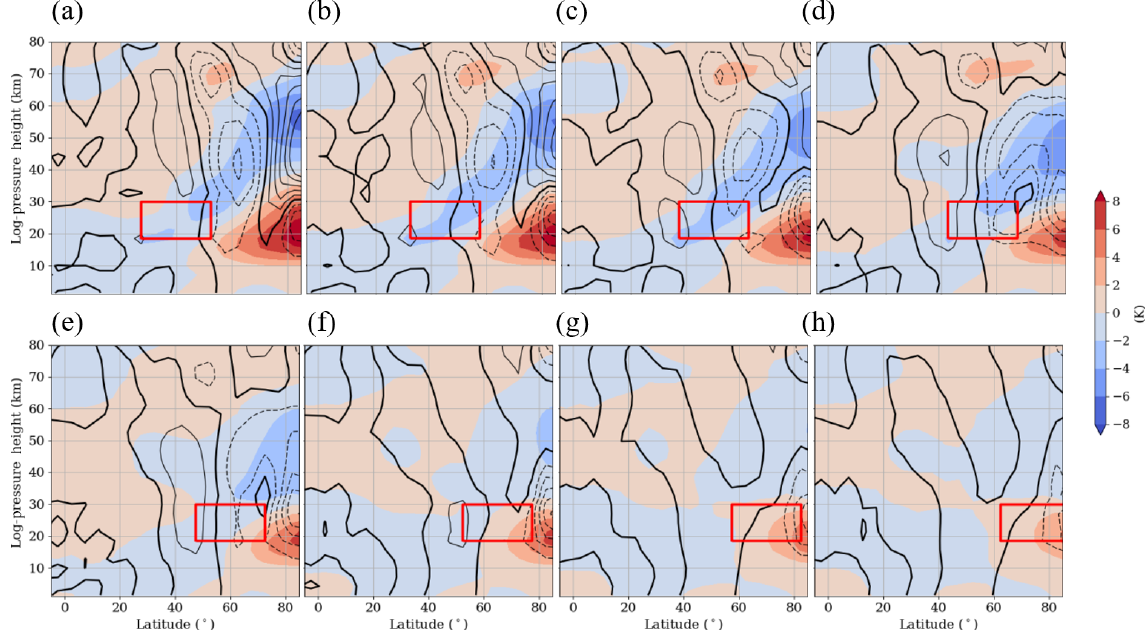
Figure 4. Zonal mean temperature and vertical wind difference between the H1–H8 simulations (a–h) and the reference simulation (H1– H8 − Ref). The colors indicate the temperature difference between the simulations, and the contour lines show the vertical wind difference from ± 0 . 0005 to ± 0 . 0025ms − 1 with increments of 0.0005ms − 1 and a thicker zero line. Negative (positive) values are shown using dashed (solid) lines. Figures represent the last 30d of the simulations. The position of each GW hotspot is represented by a red